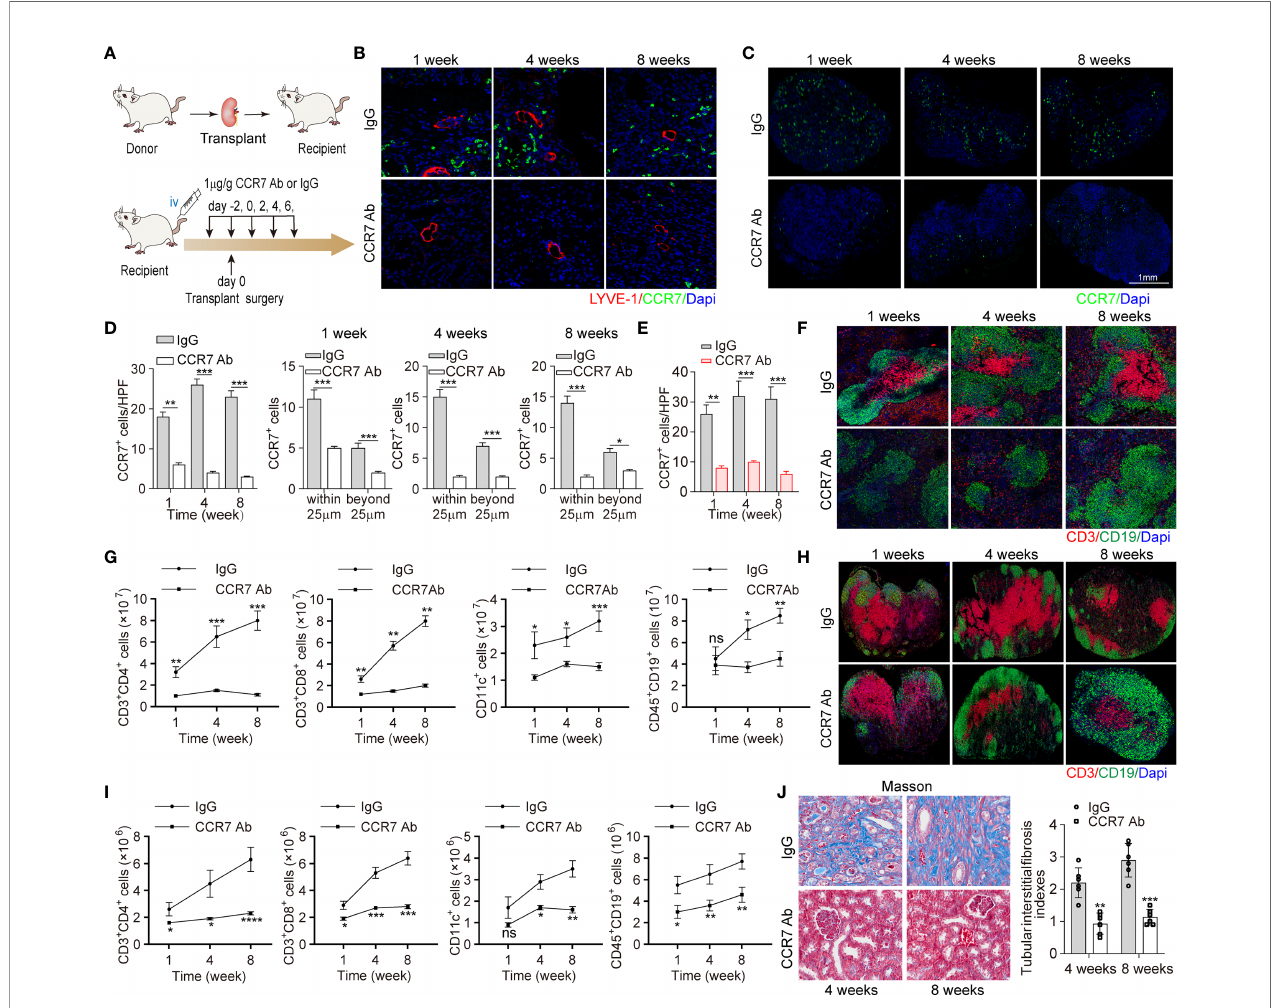
FIGURE 5 | CCR7 blocking antibody attenuated lymphocyte recruitment and allograft function losing. (A) Scheme showing recombinant anti-CCR7 antibody intervention in C57BL/6 (H-2b) mouse model (n=6 mice). Control group (n=6 mice): rabbit anti-mouse IgG. (B) LYVE-1 and CCR7 staining of kidney tissues following IgG or CCR7 antibody treatment. (C) Representative images of CCR7 in RDLN. (D) Cell counting of intrarenal CCR7 + cells at the 1, 4, and 8 weeks after surgery, including the exact cell counting within or beyond 25 m m respectively. (E) Cell counting of CCR7 + cells in RDLN. (F, H) Immuno fl uorescence staining of CD3 + and CD19 + in spleen (upper) and RDLN (bottom). (G, I) The numbers of CD3 + CD4 + and CD3 + CD8 + T cells, CD11c + DCs and CD45 + CD19 + B cells in spleen (upper) and RDLN (bottom) determined by fl ow cytometry. (J) Masson staining of renal tissues (left), and tubular interstitial fi brosis indexes (right) in recipient mice at the 4 and 8 weeks after surgery. *P < 0.05, **P < 0.01, ***P < 0.001. Values are mean ±